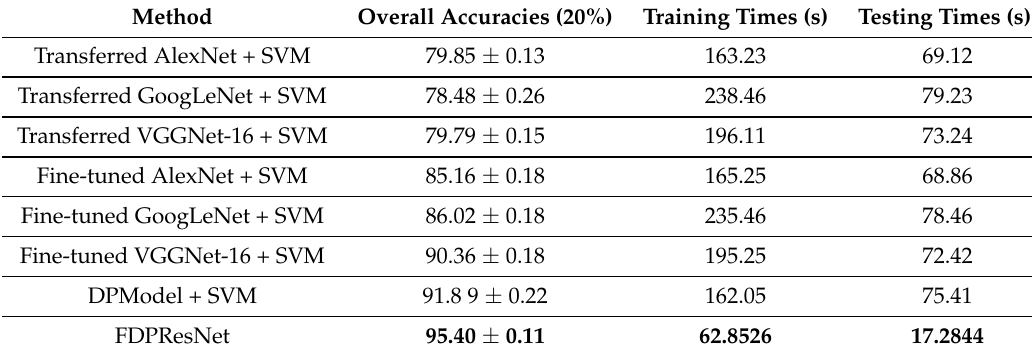
Table 2. Comparison of training time and testing time of different methods on the NWPU-RESISC45